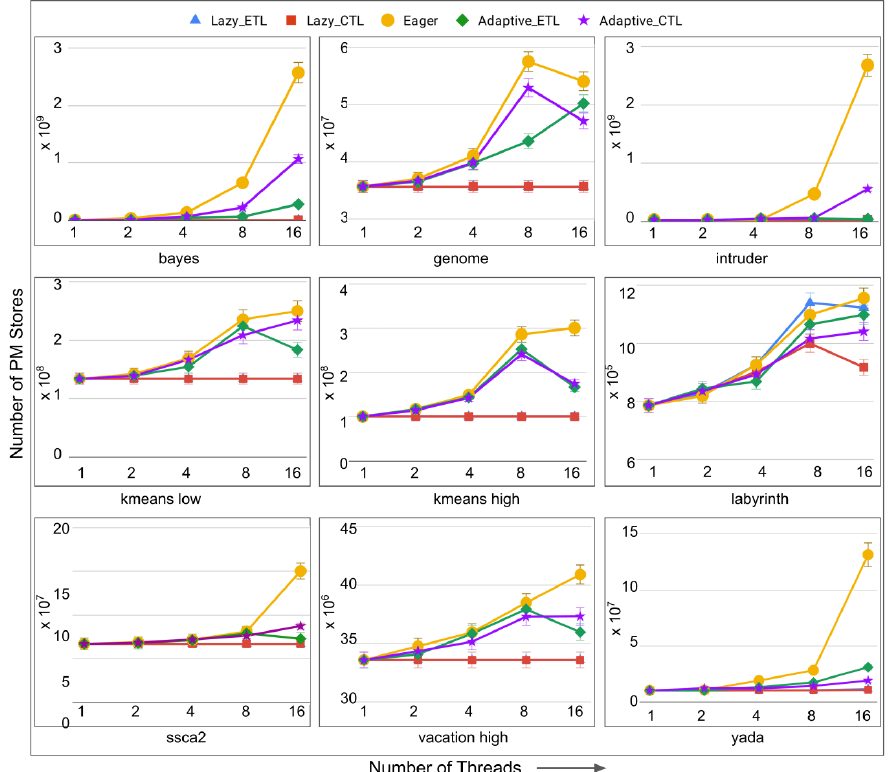
Figure 14. Total number of stores to the PM in STAMPEDE